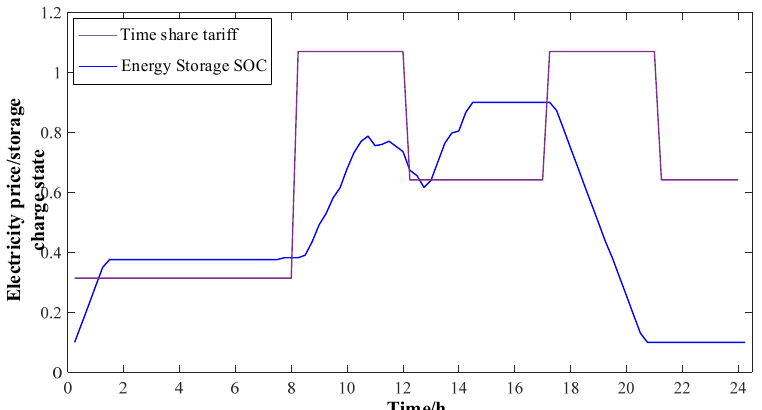
Figure 11. Time-sharing tariff and SOC change curve of energy storage system in Scenario II.